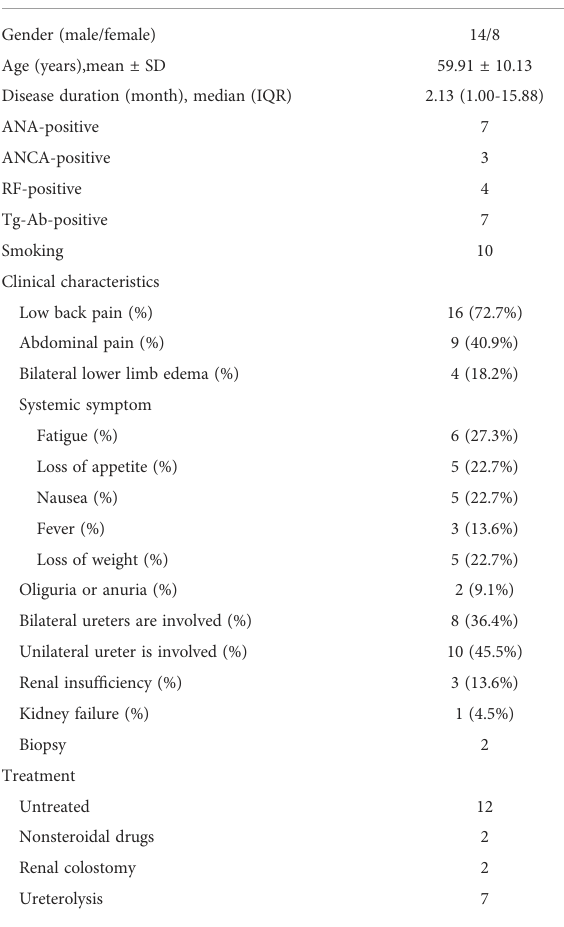
TABLE 1 Demographic and clinical characteristics of 22 patients with